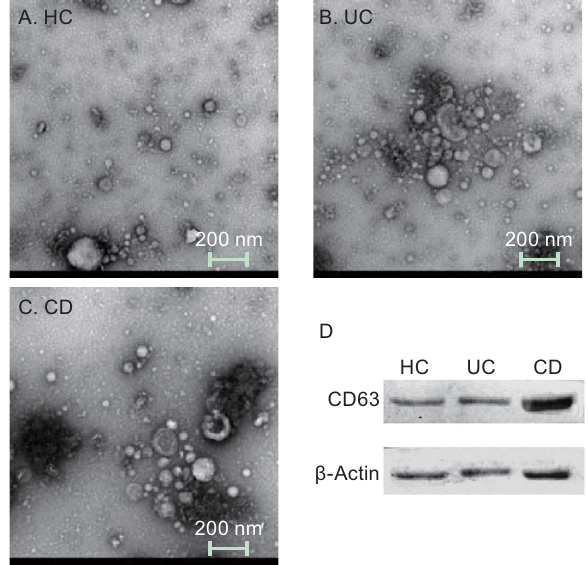
Figure 1. Electron microscopy of exosomes. (A – C) The images of salivary exosomes under electron microscopy of HC, UC, and CD patients. The scale bar is 200 nm and the exosomes are 30 – 120 nm in size and largely spherical in shape. The size of the exosomes did not differ